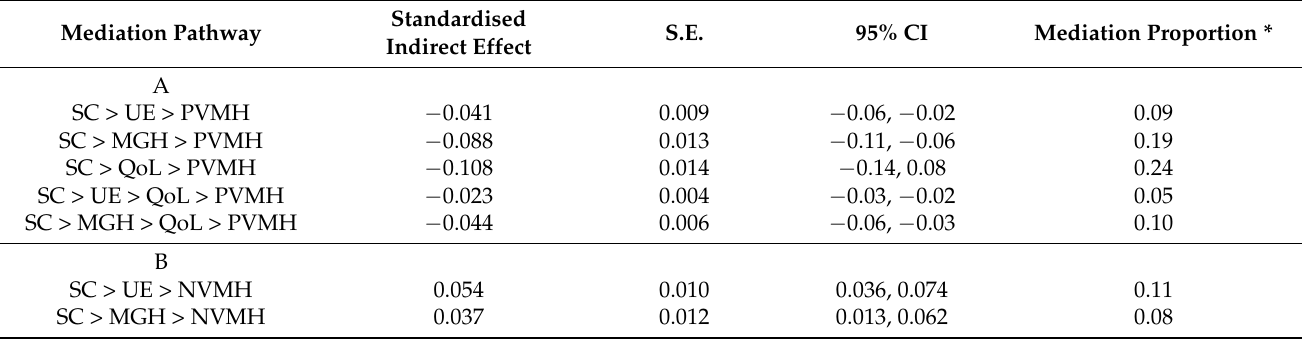
Table 3. Indirect effects for the indirect pathways explaining the relationship between secondary conditions and positive vitality/mental health ( A ) and negative vitality/mental health ( B ). Bias- corrected bootstrapping was used. SC, secondary conditions; UE, self-efficacy for unexpected events; MGH, self-efficacy for maintaining good health; QoL, self-appraisal for quality of life; PVMH, positive vitality/mental health; NVMH, negative vitality/mental